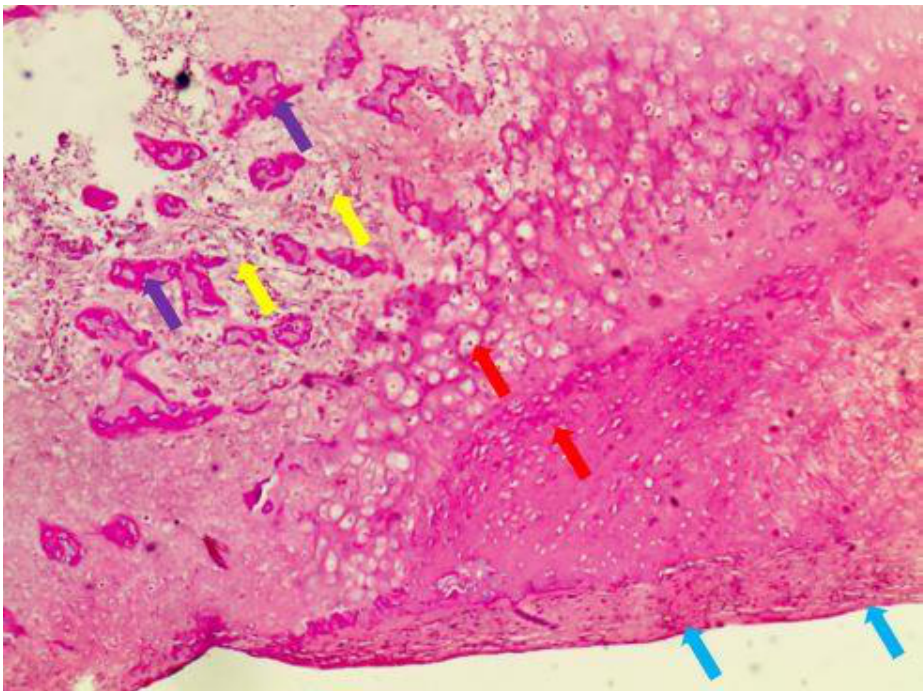
Figure 5. Hematoxylin and eosin (H&E) staining (yellow arrows — yellow marrow in the lesion; red arrows — hyaline cartilage cap with columns of cartilage cells; purple arrows — trabeculae within the osteochondroma; blue arrows — fibrous capsule or perichondrium).